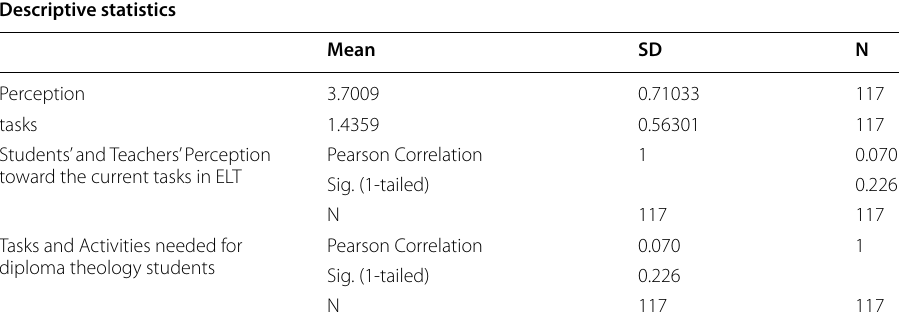
Correlation is significant at the 0.01 level (1-tailed) r 0.07, N 117, p < = =